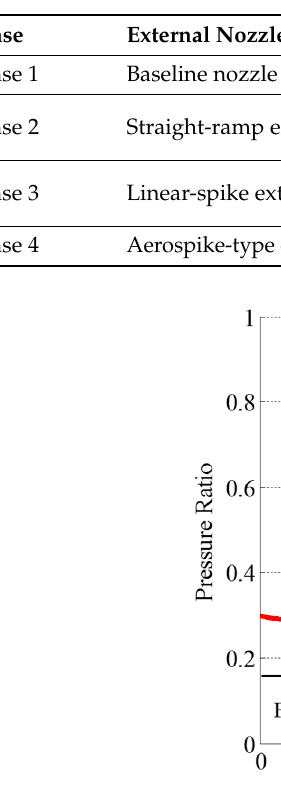
Table 2. Summary of external nozzle configurations.